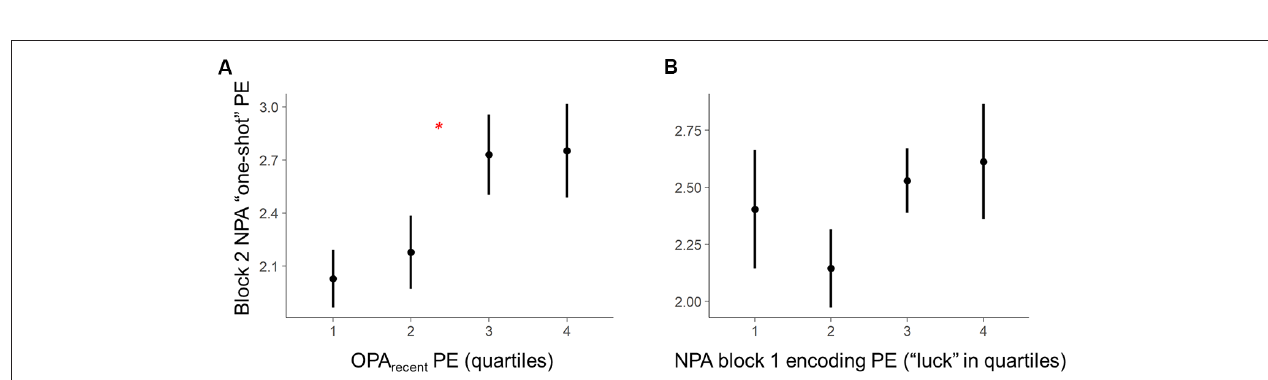
FIGURE 3 | Within-subject trial-level behavioral predictors of one-shot NPA learning. Quartiles reflect within-subject binning of environment-by-environment measures into quartiles for visualization purposes only (Linear Mixed Effects, LME analyses used continuous performance differences across each environment). (A) Performance on the most recent retrieval-practice experience with OPA items (i.e., OPA block 12) predicted NPA PE after one-shot learning (i.e., NPA block 2 performance). (B) There was a complex, curvilinear relationship between “luck” in NPA location search in NPA block 1 and one-shot learning success (controlled for in our statistical analyses). ∗ p <